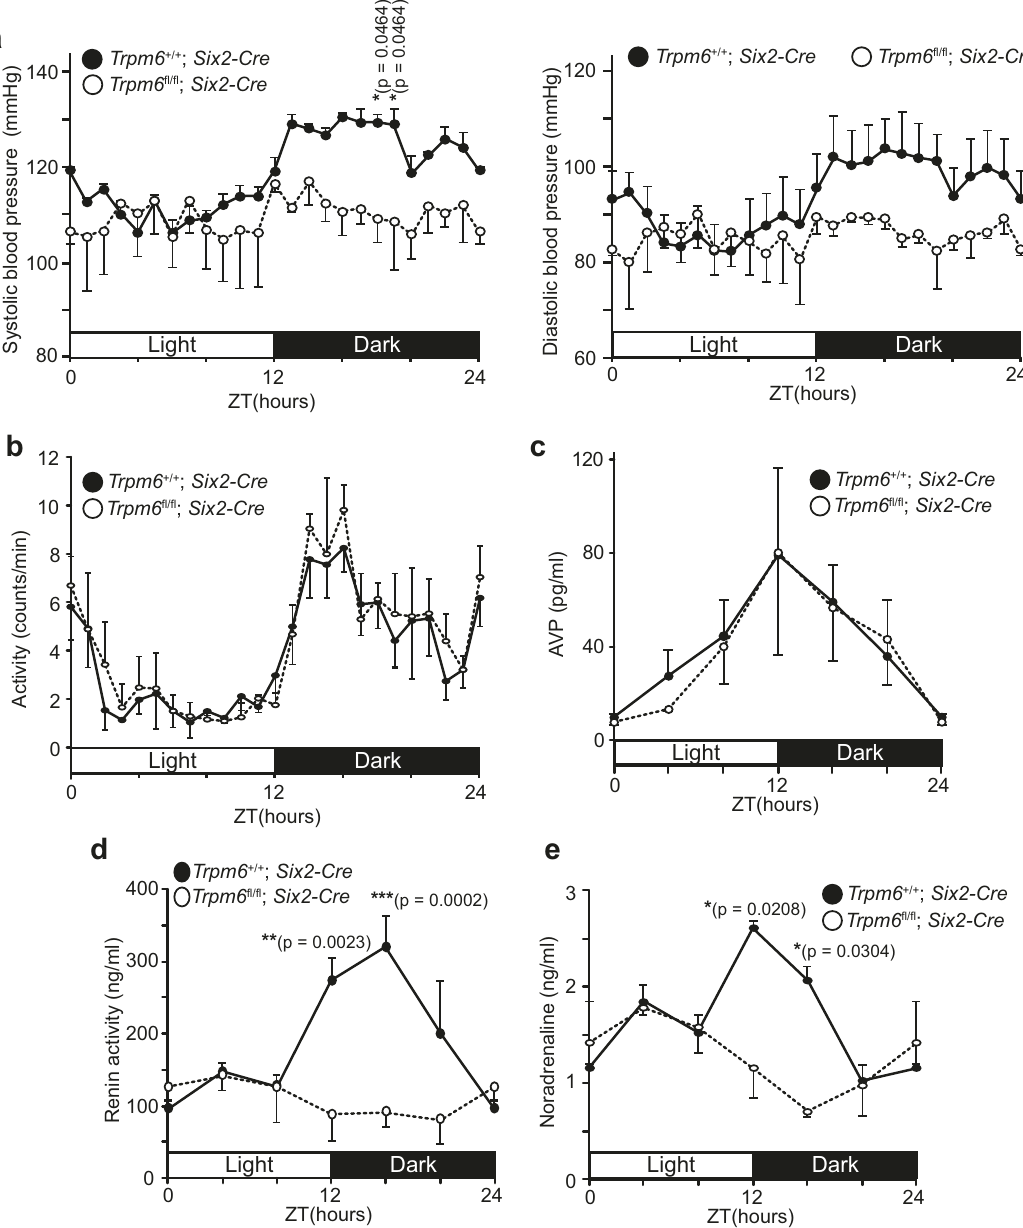
Fig. 2 Trpm6 ablation impairs circadian rhythms of blood pressure and renin activity. a Blood pressure values of 2- to 3-month-old mice of the indicated genotypes were measured with radiotelemetry. Data are shown as means±SEM for systolic (left) and diastolic (right) pressure values ( n = 4 for Trpm6 + / + ; Six2-Cre and n = 3 for Trpm6 fl / fl ; Six2-Cre ). The p -values were determined by two-way ANOVA with Holm-Sidak post hoc tests. * p < 0.05. b Locomotor activity of 2- to 3-month-old mice of the indicated genotypes. Data are shown as means± SEM ( n = 3 mice for each genotype). c – e Whole blood was collected from 2- to 4-month-old mice of the indicated genotypes at indicated time periods, and plasma AVP ( c , n = 3 mice for each genotype), renin activity ( d , n = 5 at ZT0 and ZT4, n = 6 for Trpm6 + / + ; Six2-Cre and n = 4 for Trpm6 fl / fl ; Six2-Cre at ZT8, n = 3 at ZT12, ZT16, and ZT20), and noradrenaline ( e , n = 4 at ZT0, ZT4, and ZT8, and n = 3 at ZT12, ZT16, and ZT20) were measured. Data are shown as means± SEM. The p -values were determined by two-way ANOVA with Holm-Sidak post hoc tests. * p < 0.05, ** p < 0.01, *** p <